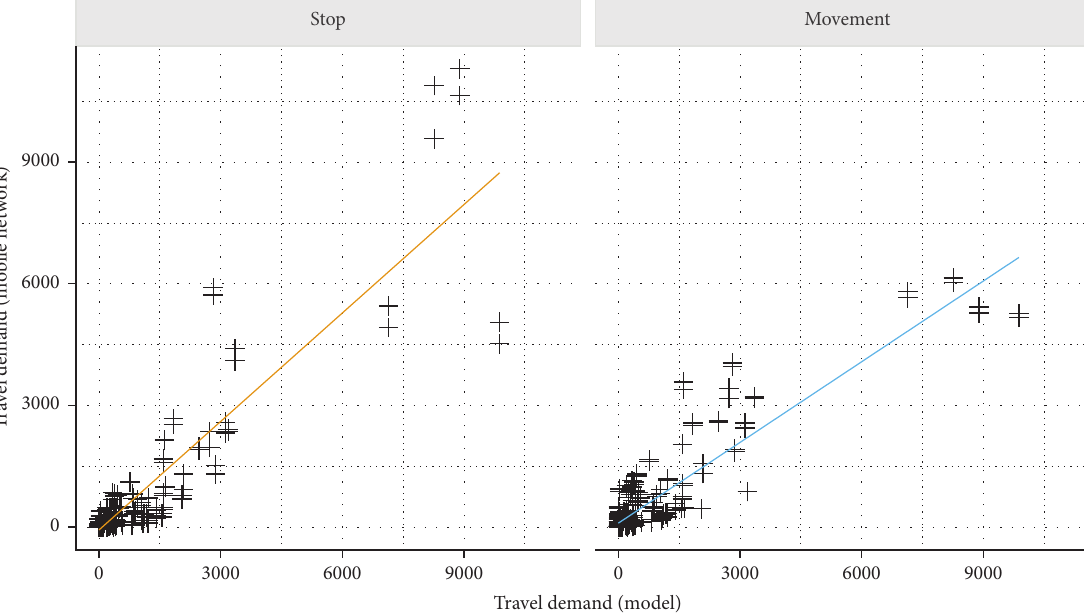
Figure 12: Correlation of the OD matrices inferred from cellular network data in comparison with the model. Each data point corresponds to an OD pair, and its average travel demands for Monday–Thursday (TAZ-24 zoning). The line shows a fitted linear model.